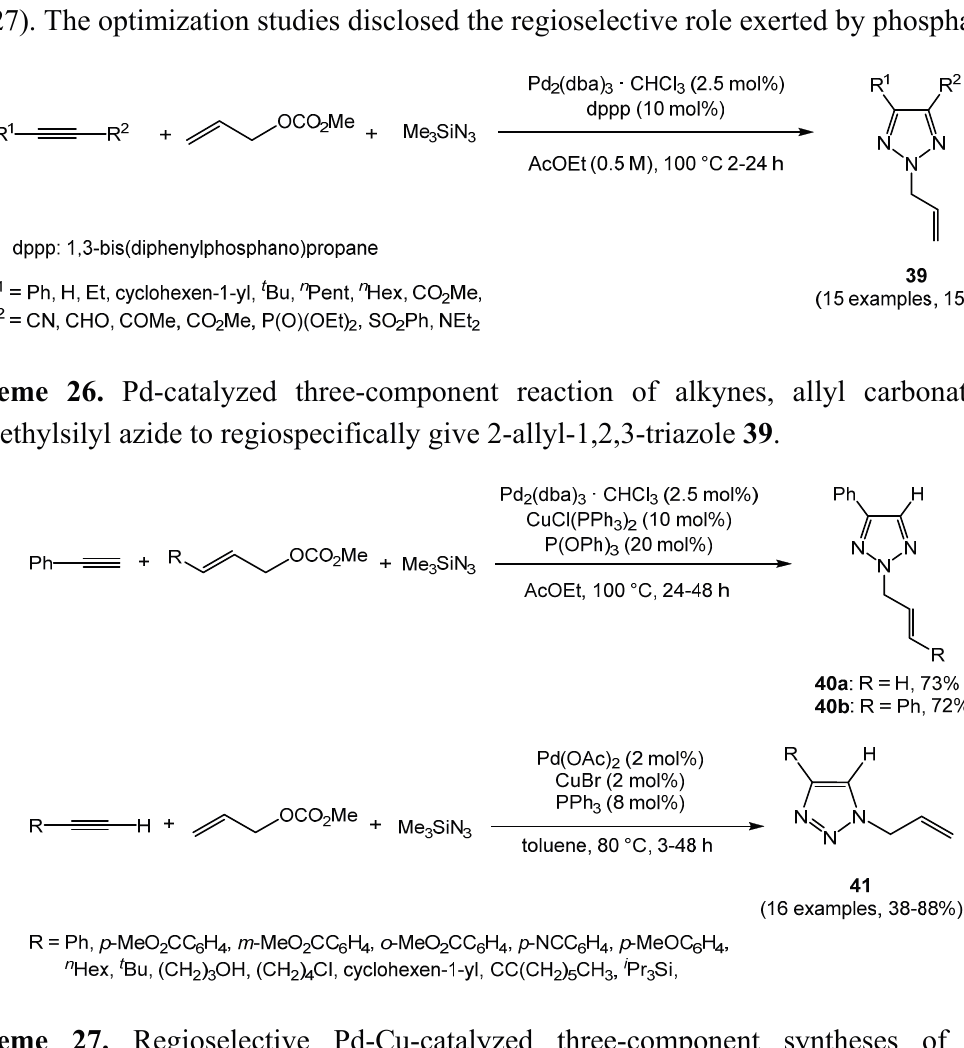
Scheme 27. Regioselective Pd-Cu-catalyzed three-component syntheses of 1-allyl 1,2,3-triazoles 40 and 2-allyl 1,2,3-triazoles 41